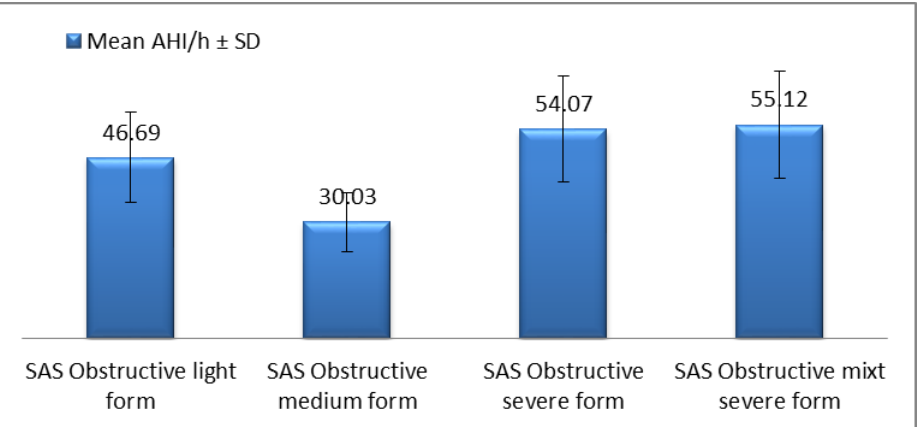
Table 1. Distribution of the AHI / h ratio by types of SAS.